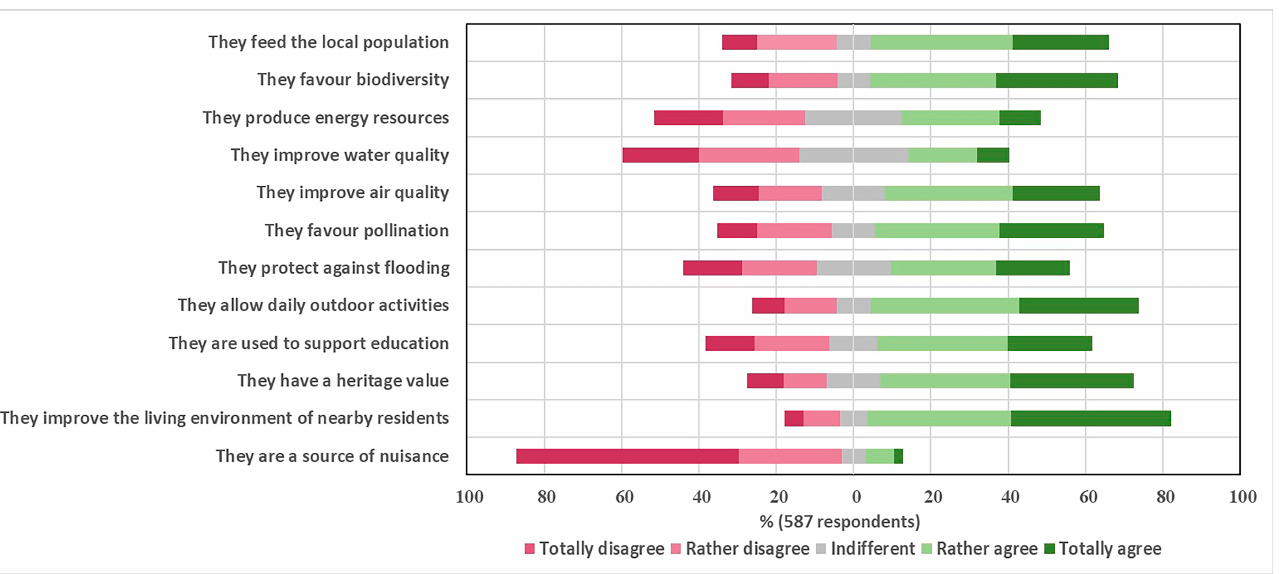
Figure 2. Perceptions of the Walloons about the services that agricultural lands can offer near their residence.